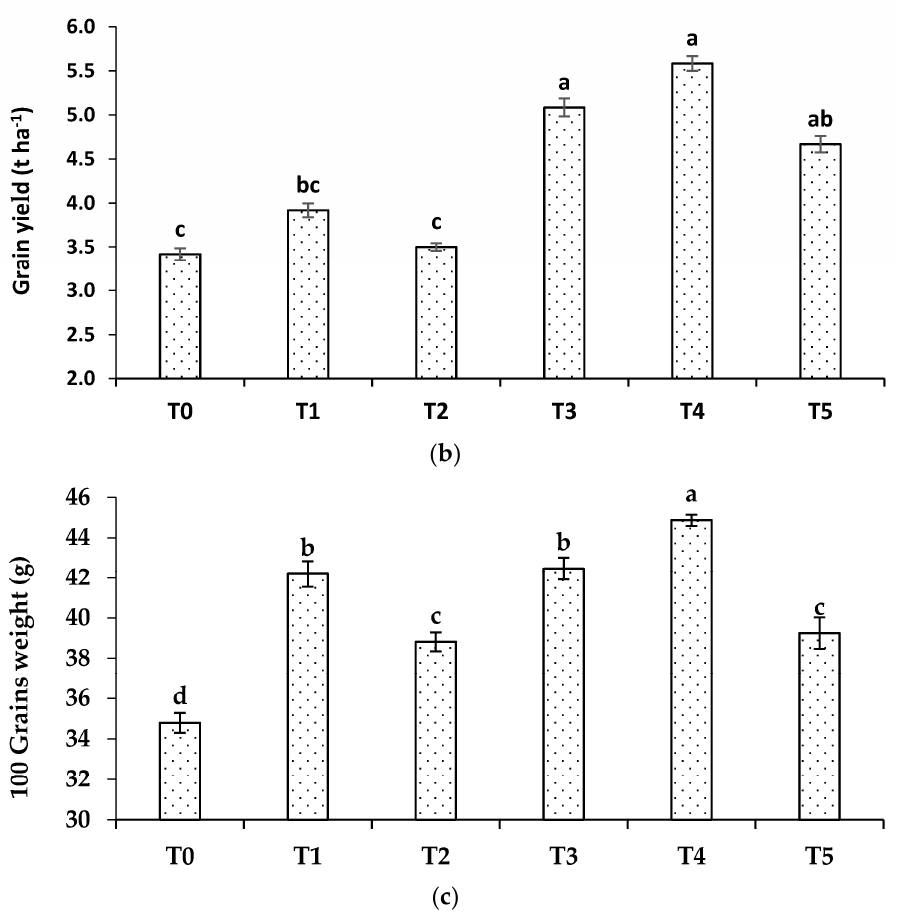
Figure 4. Comparative effectiveness of different Zn formulations of urea regarding yield parameters of wheat ( a ) Biomass (tons/ha), ( b ) Grain yield (tons/ha), and ( c ) 100 grains weight. Where T 0 = no Zn; T 1 = recommended Zn (ZnSO 4 ); T 2 = ZSB; T 3 = 1.5% Zn coated urea (ZnO); T 4 = 1.5% bio-activated Zn coated urea (ZnO); and T 5 = 1.5% Zn blended urea (ZnO). Means sharing the same letters do not differ significantly (p < 0.05).